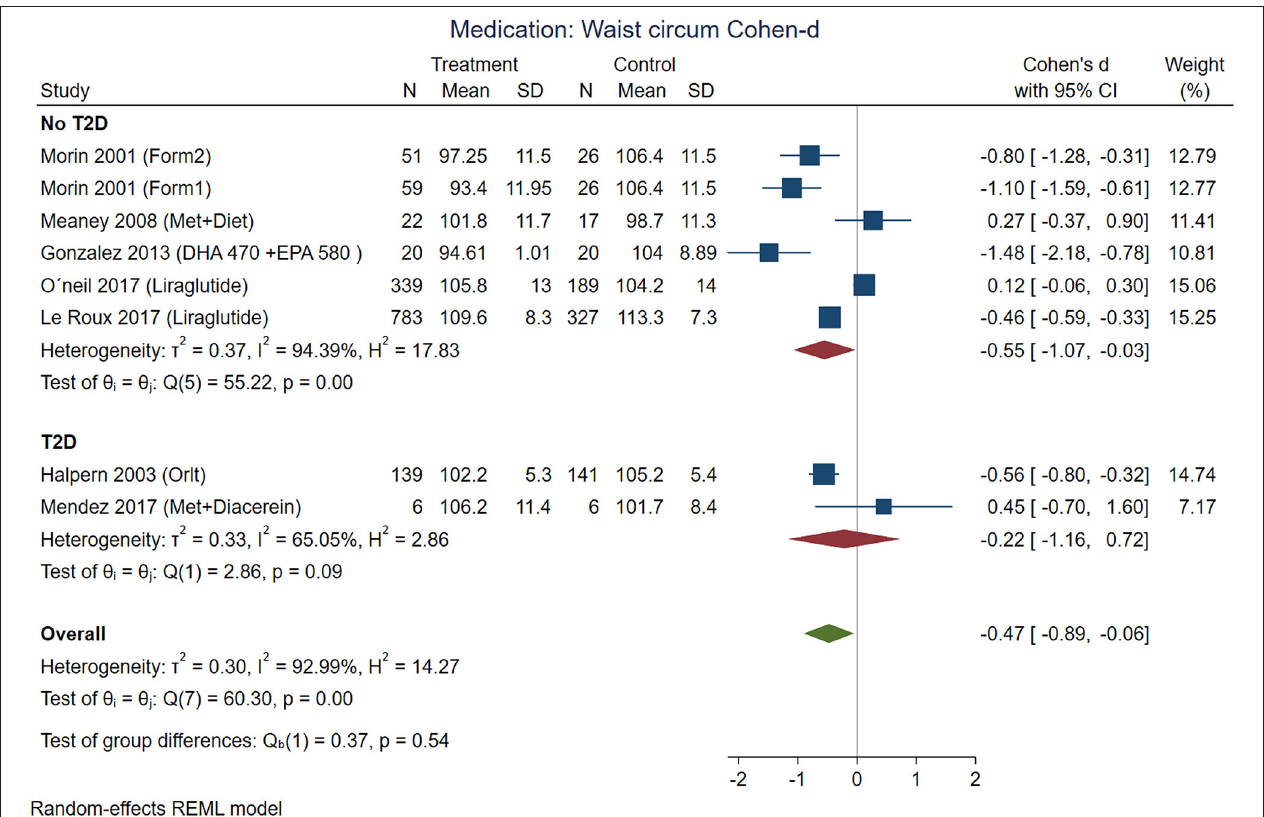
FIGURE 8 | Pooled analysis of Cohen’s d-weighted effect size on waist circumference with drug (medication) treatment. The analysis was stratified by T2D status. The Form1 and Form2 are described in the text, they are not approved by FDA. Met, Metformin; Sibut, Sibutramine; DHA, Docosahexaenoic acid; EPA, Eicosapentaenoic acid; Orlit, Orlistat; Glim, Glimepiride; Phent, Phentermine; Top, Topiramate; REML, Restricted maximum